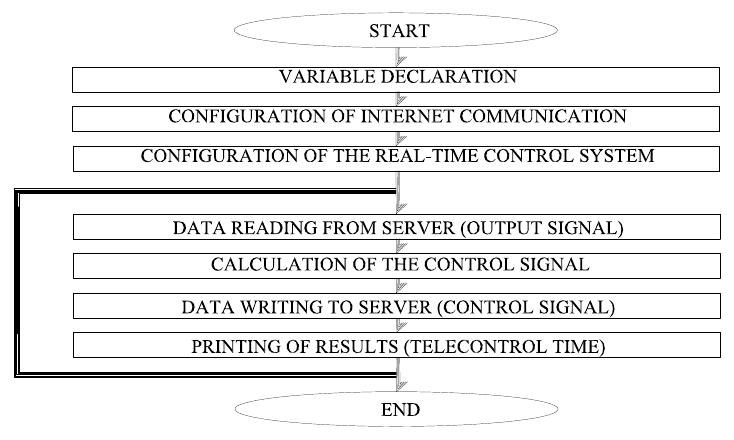
Figure 4. User interface flow diagram developed for Client A in the telecontrol system.